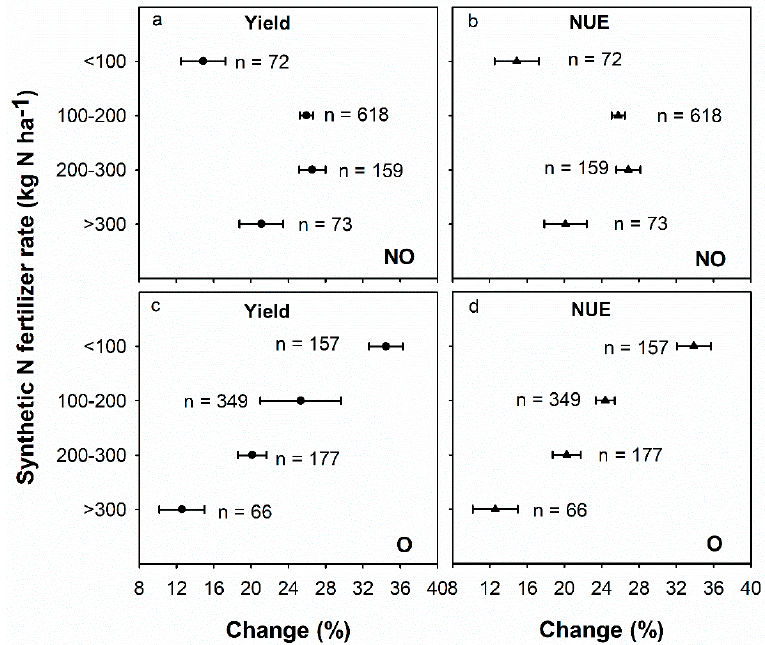
Figure 6. Response of change in potato yield ( a , c ) and NUE ( b , d ) to mulching compared to no-mulching control at different levels of synthetic nitrogen (N) fertilizer rates. Error bars represent 95% confidence intervals. The values for n represent the corresponding number of observations. NO, without organic fertilization; O, with organic fertilization.